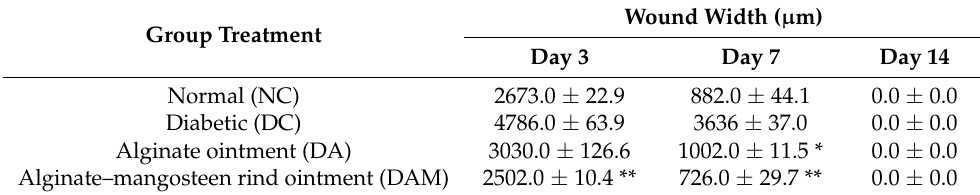
Table 3. Counts considering the mean and standard deviation of wound width.